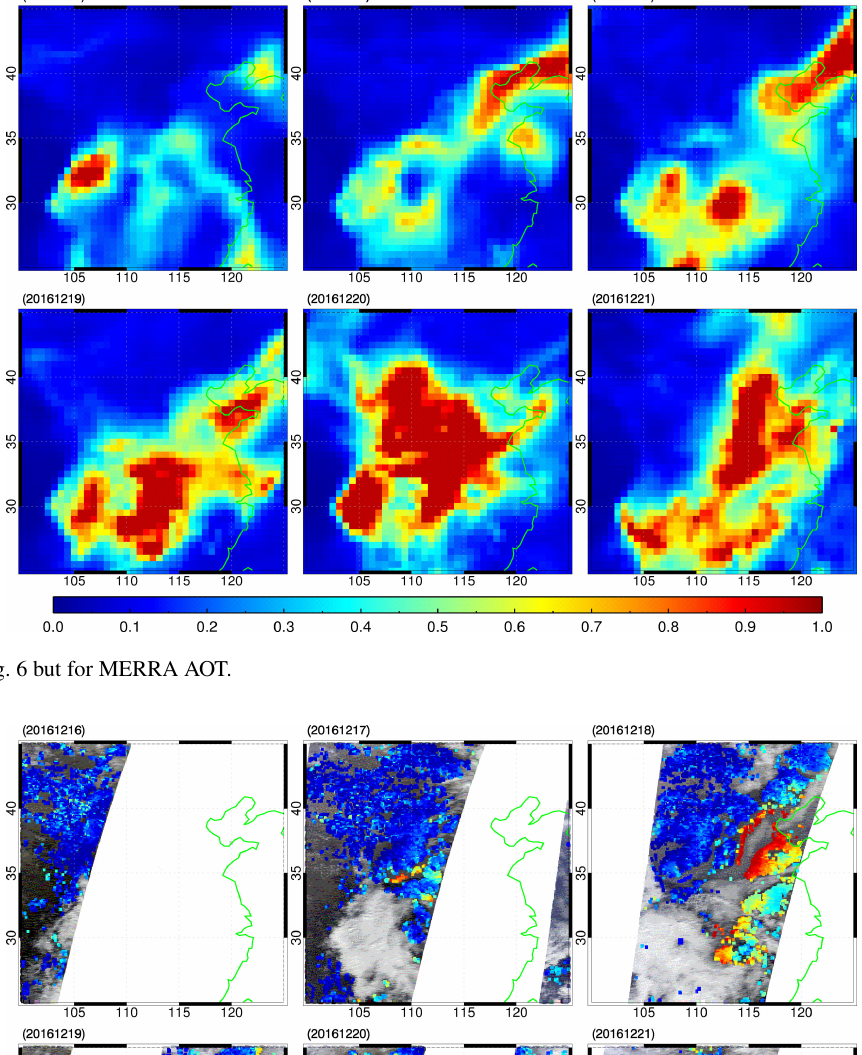
Figure 8. Same as Fig. 6 but for